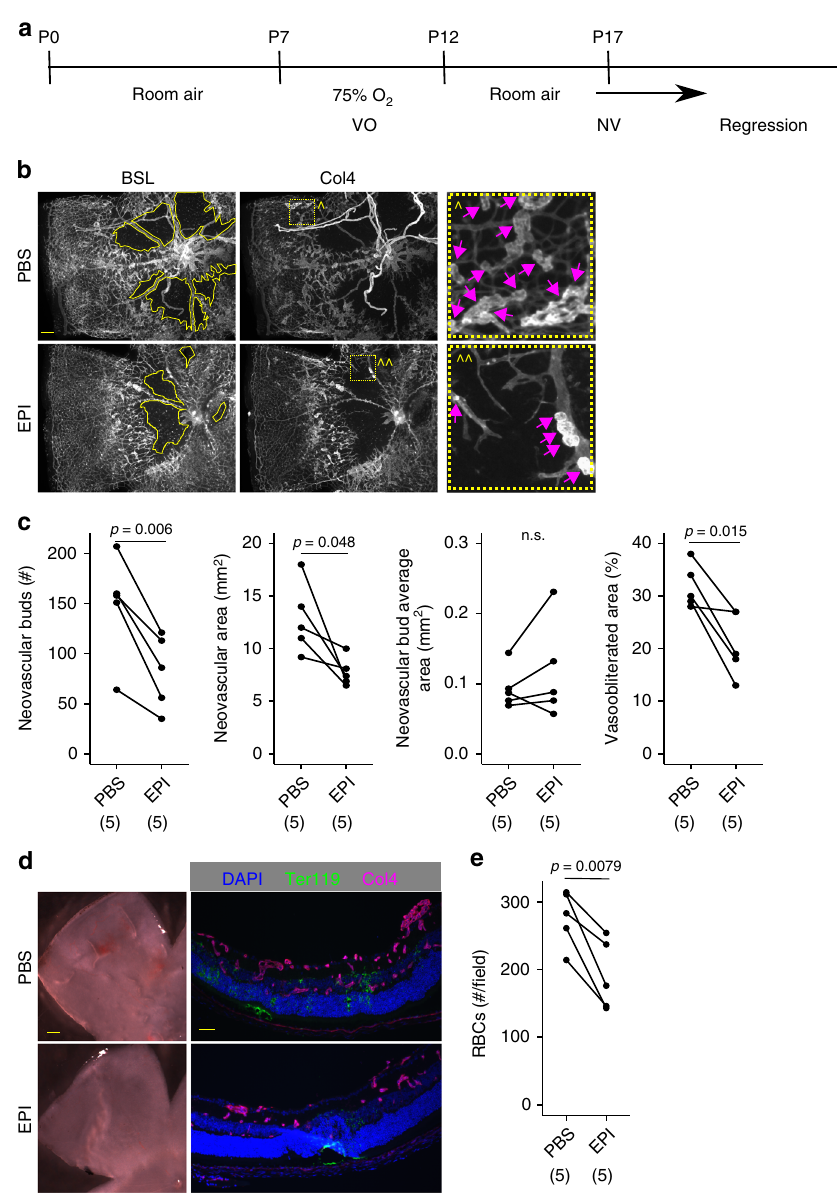
Fig. 4 Inhibition of SAC activity decreases neovascularization and hemorrhage in OIR. a Mouse pups were raised on room air until P7, when they were transferred to a 75% O 2 chamber. At P12 the pups were removed from the hyperoxic chamber and placed back into room air. P7 – P12 is the vaso- obliterative (VO) phase when previously established vessels regress. From P12 to P17 the retina undergoes profound pathological neovascularization (NV), and then from P17 to P25 the neovessels gradually regress. We inhibited cholinergic activity from P12 to P17 with every other day EPI injections and examined the retinas at the peak of neovascularization. b BSL was used to visualize the amount of vaso-obliteration and anti-Collagen IV (Col4) to visualize the bright basement membrane of preretinal neovascular buds. Zoomed in box shows examples of neovascular buds from the areas indicated by the hatched boxes. Scale bar is 200 µ m. c The number of neovascular buds, total area of neovascularization, and area of vaso-obliteration all decreased after SAC inhibition, but there was no change in the average size of each neovascular bud (n.s. is not signi fi cant). d Intraretinal hemorrhage was visible by bright fi eld imaging of freshly dissected retinas, and by anti-Ter119 staining of fi xed retinal sections. Scale bar is 200 µ m on the left, 50 µ m on the right. e SAC inhibition decreased the number of RBCs in the retina. In c , e , statistical tests are Student ’ s two-tailed t tests, paired for comparing control and treated eyes from the same animal. Number of independent samples in each group is in parentheses under the X -axis data suggest that further study of cholinergic activity may help uncouple these results extend this broad category of therapeutics to potential these mechanisms. Further work should de fi ne the role of cholinergic use in neovascular disease. signaling and the activity of other neurotransmitter-speci fi c circuits in neovascular diseases of adulthood, such as wet age-related macular degeneration and proliferative diabetic retinopathy, as well as inves- tigate the speci fi c circuits responsible for angiogenesis in different CNS compartments. Given the range of pharmacological modulators known to act on receptors and enzymes of the cholinergic pathway,